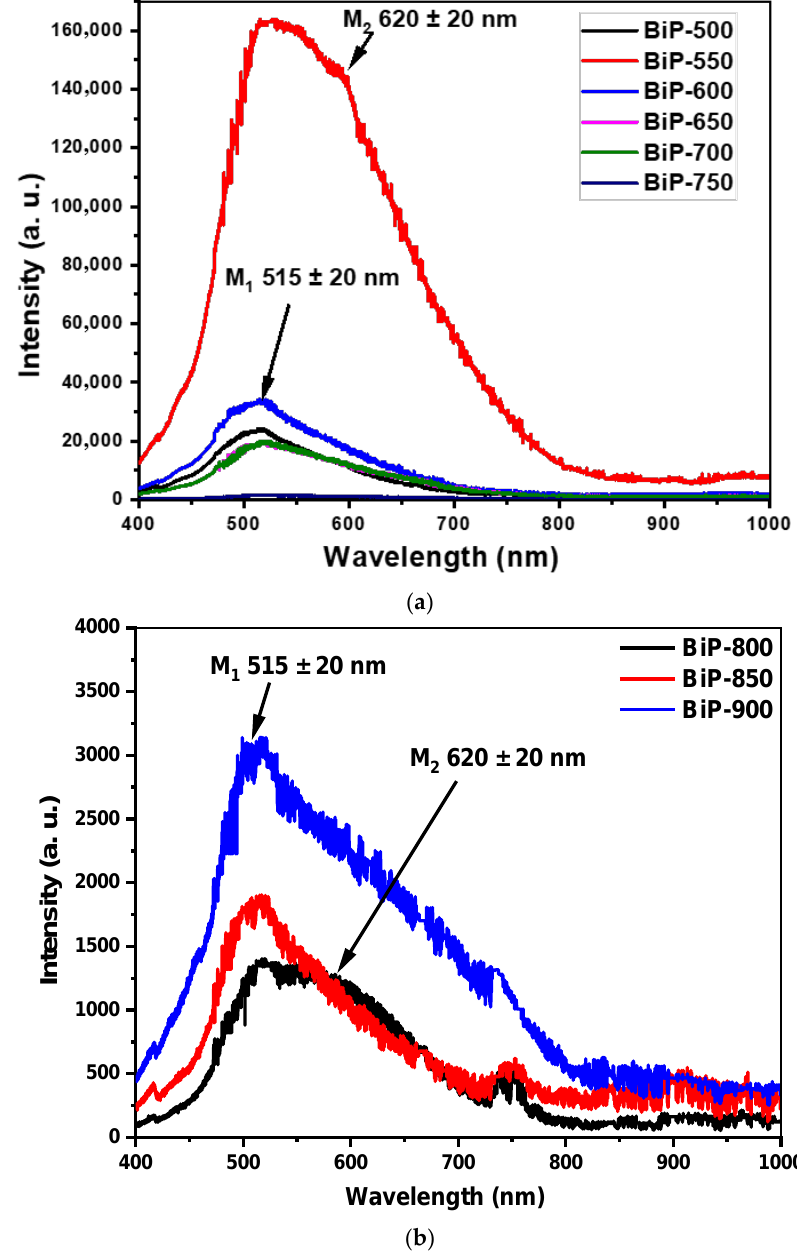
Figure 8. UV-excited photoluminescence spectra (364 nm) of BiPO 4 prepared by solid state reaction and heat treated at ( a ) 500, 550, 600, 650, 700 and 750 °C, ( b ) 800, 850 and 900 °C. In Figure 9, we have reported the intensities of the maximum bands as a function of the heat treatment temperature Θ . The two characteristic bands of phase M 1 (515 ± 20 nm) and M 2 (620 ± 20 nm) show almost invariant intensities with Θ. We observed a maximum for the polymorph sample BiP-550 (M 1 and traces of M 2 ). The intensity observed for this particular sample is more than five times greater than that observed for the pure phase BiP-500 (monoclinic M 1 ) and one hundred times greater than that of BiP-750 and BiP-800 (monoclinic M 2 ). These results of photoluminescence under UV (364 nm) are in good